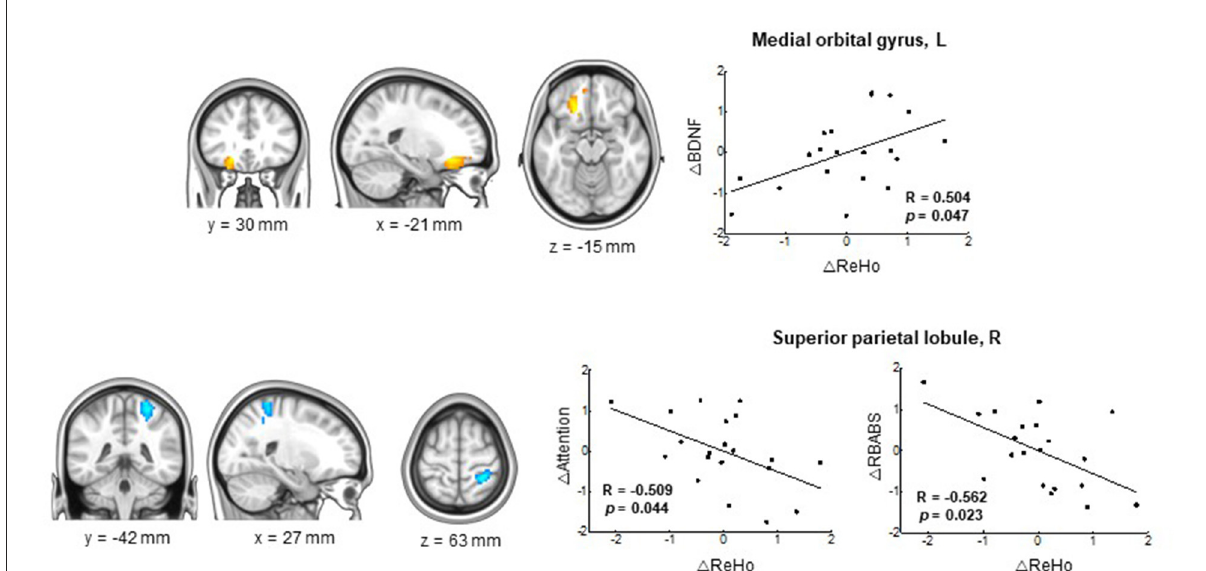
FIGURE3 Correlations between longitudinal changes in ReHo and RBANS score and serum BDNF in the FMI group. Significant correlation was found between the serum BDNF and longitudinal changes in ReHo in the left medial orbital gyrus (upper panel) and between the attention/RBANS total scores and longitudinal changes in the ReHo in the right superior parietal lobule (lower panel) in the FMI group. A positive correlation was found between longitudinal changes in ReHo in the left medial orbitofrontal gyrus and BDNF in the FMI group. Negative correlations were found between longitudinal changes in ReHo in the right superior parietal lobule and attention/RBANS total scores in the FMI group. BDNF, brain-derived neurotrophic factor; FMI, facility-based multidomain intervention; HMI, home-based multidomain intervention; RBANS, Repeatable Battery for the Assessment of Neuropsychological Status; ReHo, regional homogeneity.